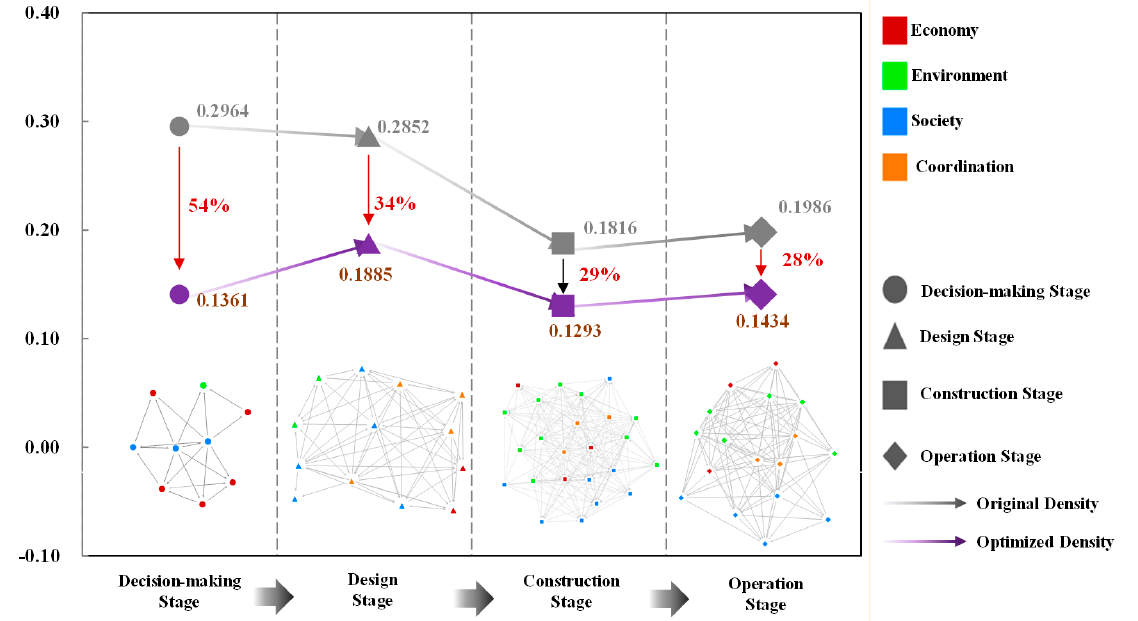
Figure 9. Evolution of network density of optimized risk network.